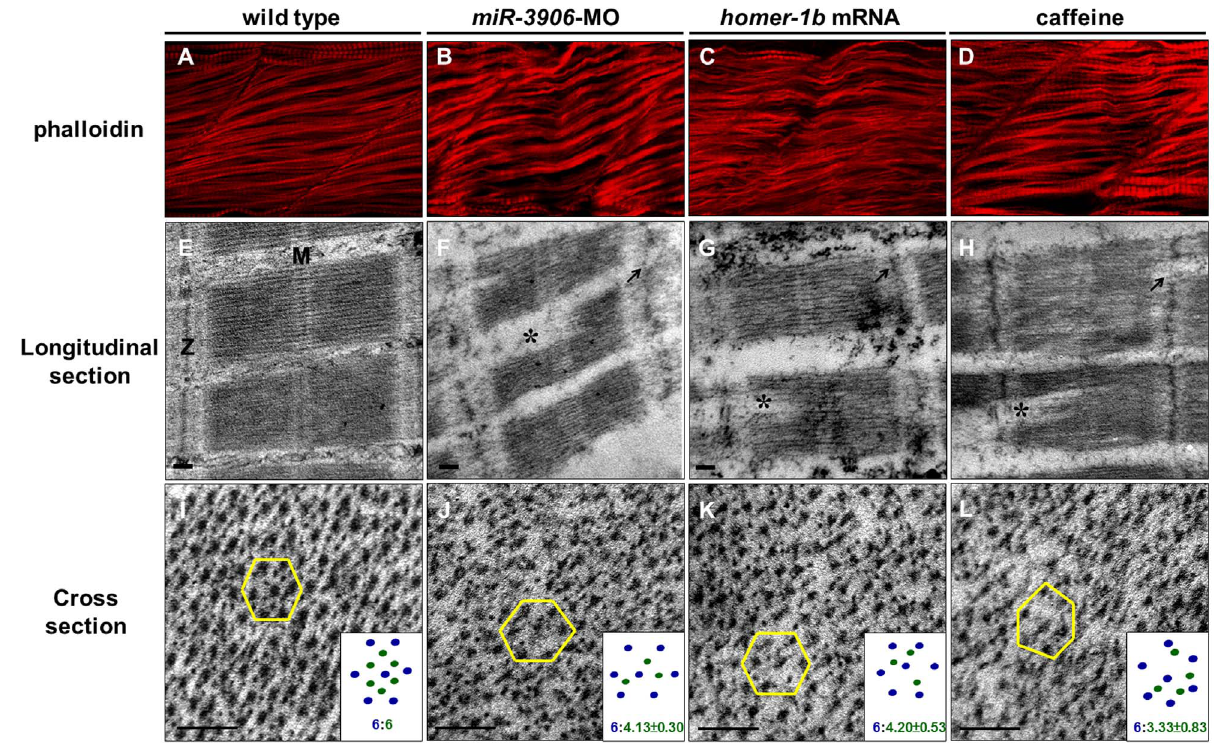
Figure 7. Either inhibition of miR-3906 or overexpression of homer-1b disrupts sarcomeric actin organization. Using phalloidin stain, compared to ( A ) WT embryos, ( B ) miR-3906- MO-injected embryos, ( C ) homer-1b- mRNA-injected embryos and ( D ) caffeine-soaked embryos exhibited a bending and disruption of sarcomeric actin organization in muscle cells. In longitudinal section, compared to ( E ) WT control embryos, ( F ) the Z-disc structure displaying in miR-3906- MO-injected embryos, ( G ) homer-1b- mRNA-injected embryos and ( H ) caffeine-soaked embryos was chaotic (indicated by arrows), and the full-length sarcomeres in muscle fibers were interrupted (indicated by asterisks) and could not be seen completely in a full sarcomere line. In cross section, compared to ( I ) WT control embryos, the relative position and proportion between myosin heavy chain and actin filament among the ( J ) miR-3906- MO-injected embryos, ( K ) homer-1b- mRNA-injected embryos and ( L ) caffeine-soaked embryos were chaotic and extremely irregular. For each sample, we randomly selected five positions to identify their hexagonal arrangements and calculated the ratio between the thick and thin filaments (n=3). Results were presented at the bottom right of each picture ( I–L ). M:M line;Z:Z-disc;scale bar:0.1 m m.